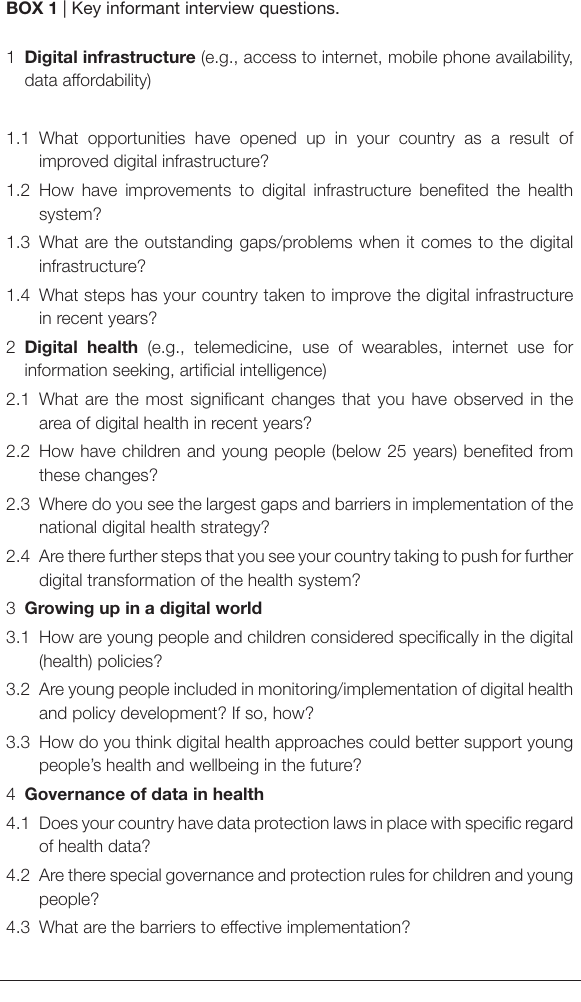
TABLE 8 | Profile of experts interviewed for the